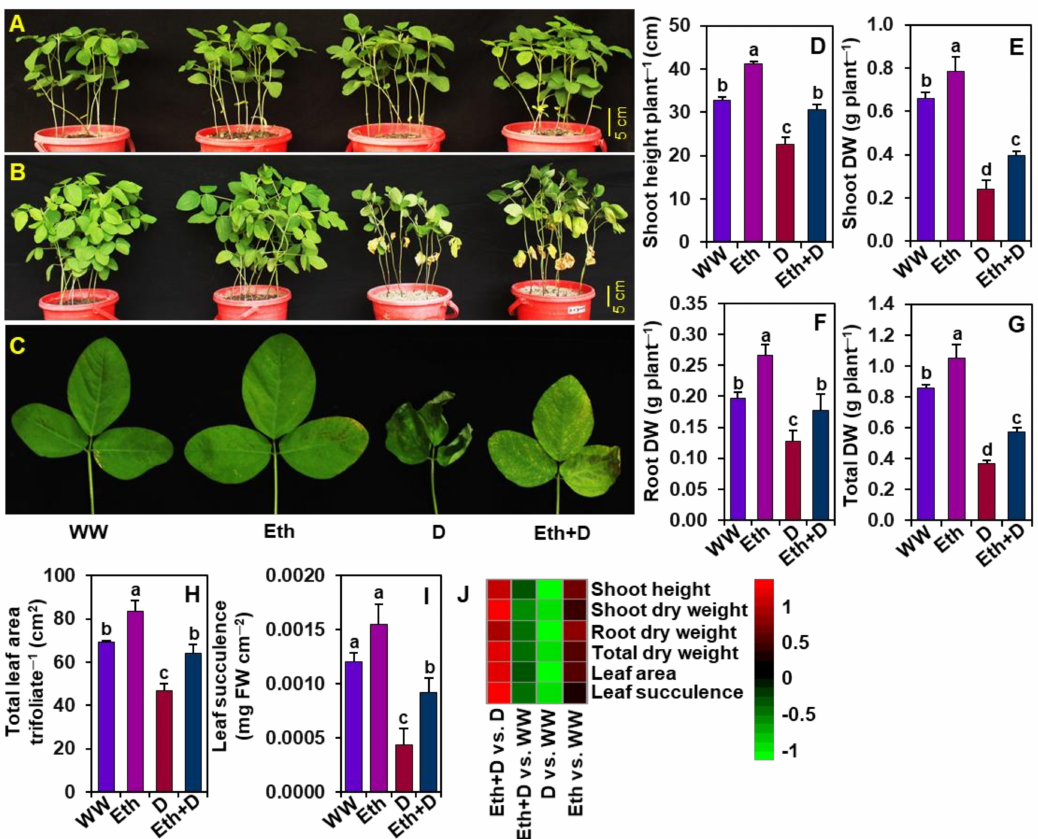
Figure 1. Effect of exogenously supplied 20-mM ethanol on soybean plants exposed to 8 days of water-withholding-induced drought stress. Photographs of soybean plants were taken before ( A ) and after ( B ) exposure to drought stress. ( C ) Close-up photographs of representative soybean leaves (first trifoliate from the bottom of the plant) from each treatment. ( D ) Shoot height, ( E ) shoot DW, ( F ) root DW, ( G ) total DW, ( H ) total leaf area per trifoliate, and ( I ) leaf succulence of soybean plants under different treatments. ( J ) Heatmap of the fold-change values of the aforementioned morphological parameters in soybean plants under different treatments. Bars represent means with standard errors ( n = 4). Different letters shown above the bars are used to indicate significant differences among the treatments ( p < 0.05). WW, Eth, D, and Eth + D indicate water-sprayed well-watered